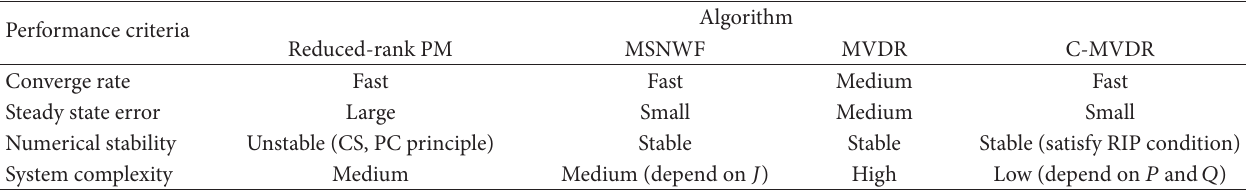
Table 1: Performance comparison of different beamforming algorithms.